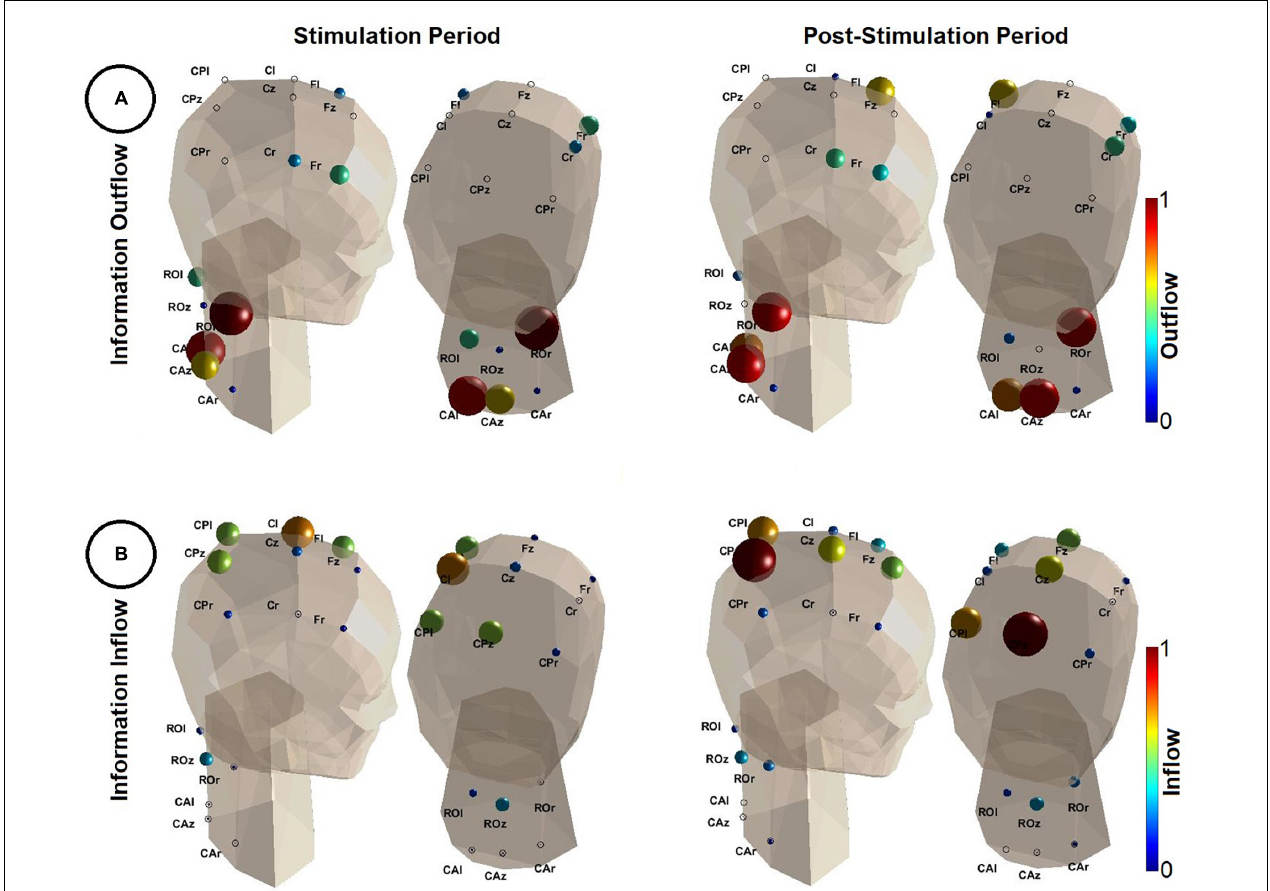
FIGURE 4 | Results of the directional connectivity estimation during the stimulation ( t = [0, 1] s–left panel) and the post-stimulation period ( t = [1, 2] s–right panel). (A) Depicts the information outflow (Eq. 5) in the frequency range of [0.5, 60] Hz. Note that the color (color coded based on the color bars shown on the right of each image) and the size of each sphere quantifies the amount of information outflow from a specific region. The larger the spheres and the darker their red, the higher the information outflow from the corresponding regions. Outflow values were normalized by the maximum outflow value detected in both analyzed time periods (i.e., stimulation and post-stimulation). The head model is shown from two different angles. (B) Depicts the information inflow (Eq. 6). Similarly as in (A) , the larger the spheres and the darker their red, the higher the information inflow of the corresponding regions. Inflow values were normalized by the maximum inflow value detected in both analyzed time periods. A 3D animation can be found in Supplementary Material (Video 2.avi for outflow during stimulation, Video 3.avi for inflow during post-stimulation, Video 4.avi for inflow during stimulation and Video 5.avi for outflow during post-stimulation). This figure was inspired by the eConnectome toolbox (He et al.,